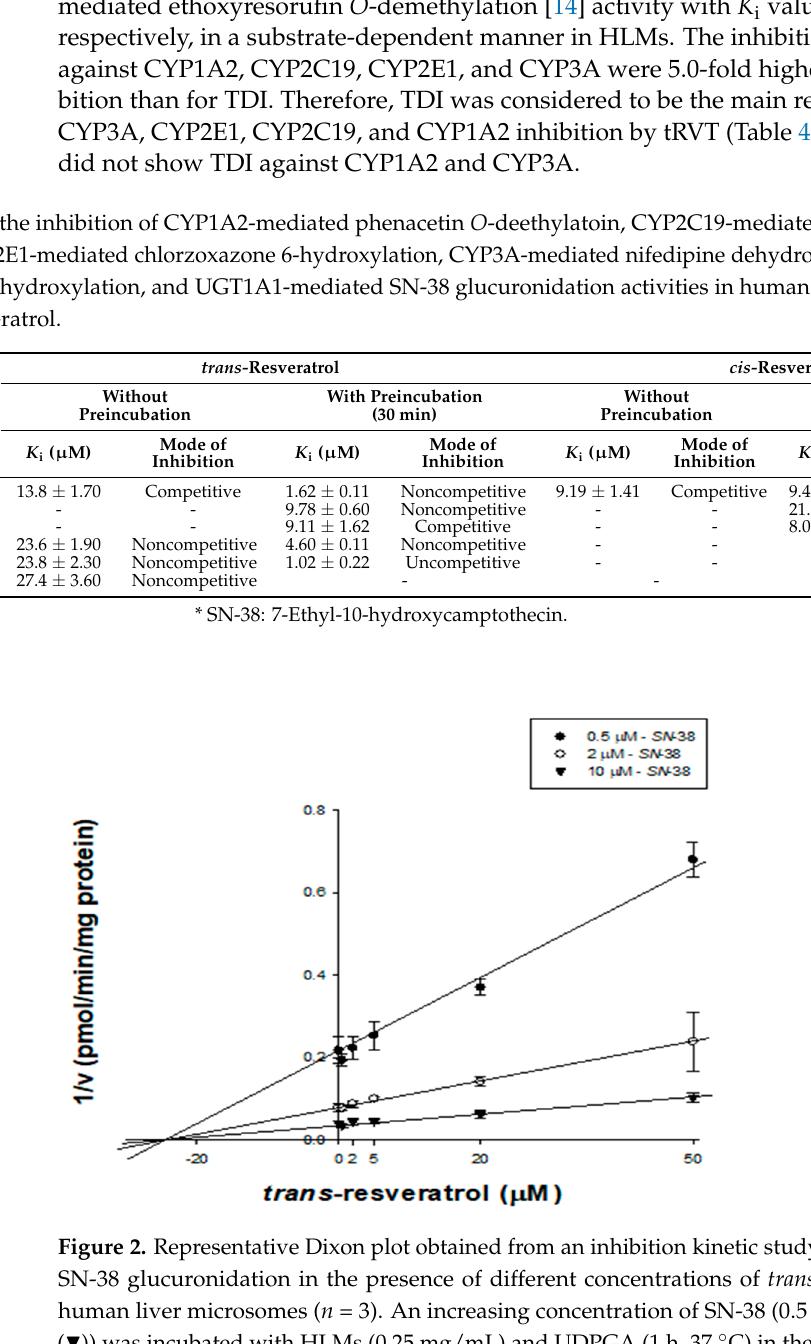
), and 10 µ M (cid:35)